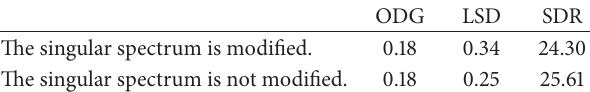
Table 9: ODGs, LSDs, and SDRs: comparison of the proposed scheme when the singular spectrum is modified and when it is not modified to embed the watermark bit 0 . ODG LSD SDR The singular spectrum is modified. The singular spectrum is not